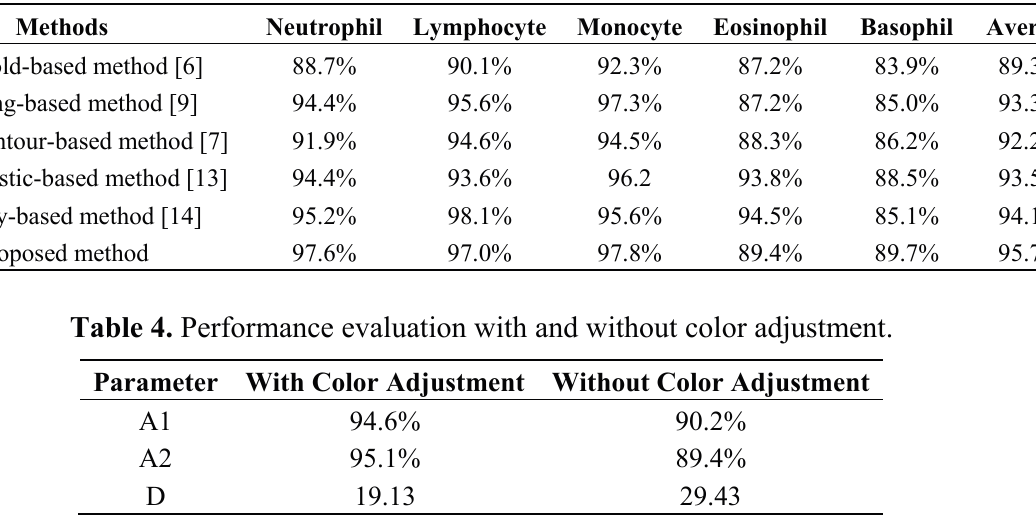
Table 3. Performance evaluation of each types of WBC separately.